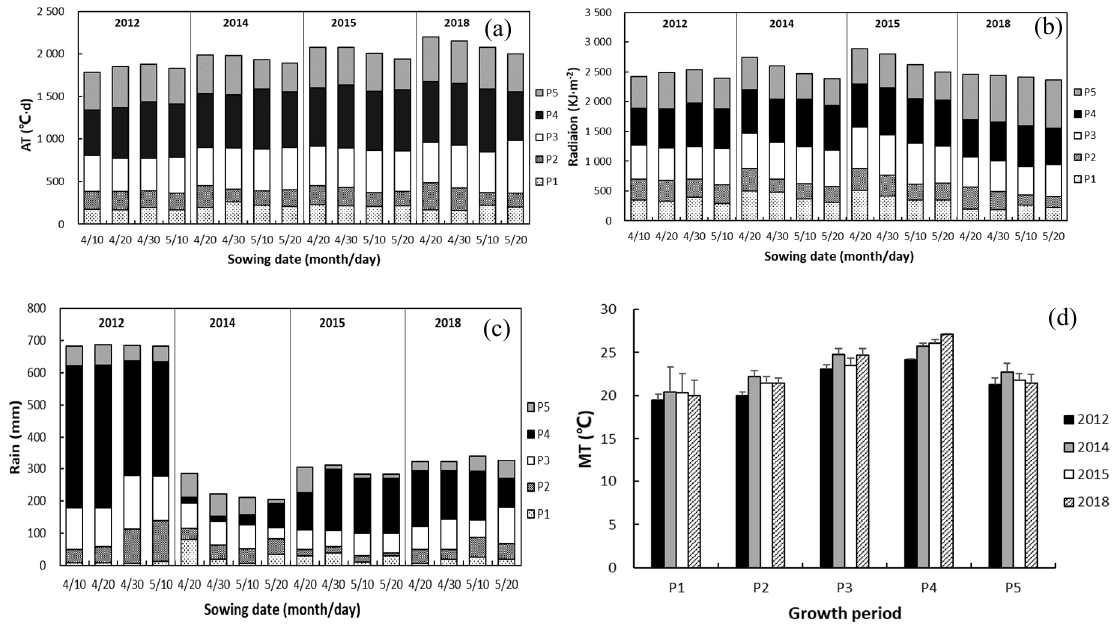
Figure 2. Meteorological conditions during different growth stages of maize sown on different dates: ( a ) AT, ( b ) Radiation, ( c ) Rain, and ( d ) MT .